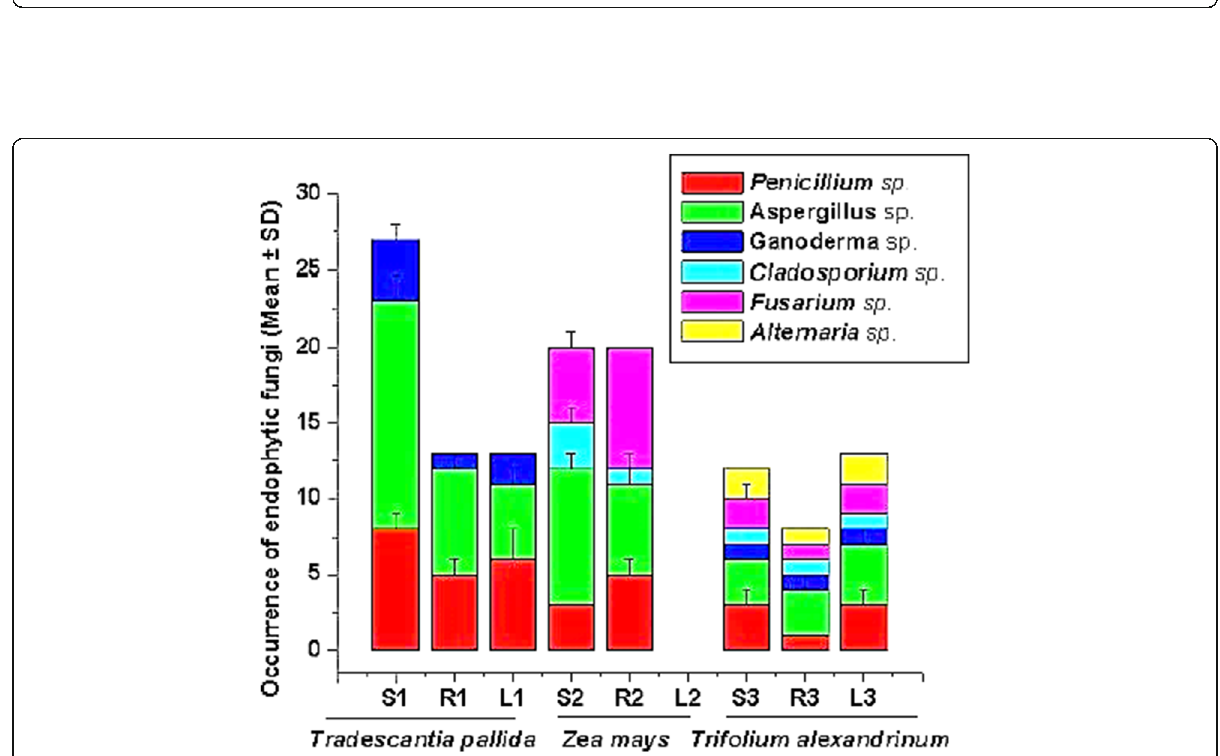
Fig. 2 Distribution of endophytic fungi in different parts (stem, root, and leaves) of Tradescantia pallida (S1- the stem, R1-root, L1-leaf) Zea mays (S2- the stem, R2- root, L2-leaf) and Trifolium alexandrinum (S3-stem, R1-root, L3-leaf; bar indicates the ±standard